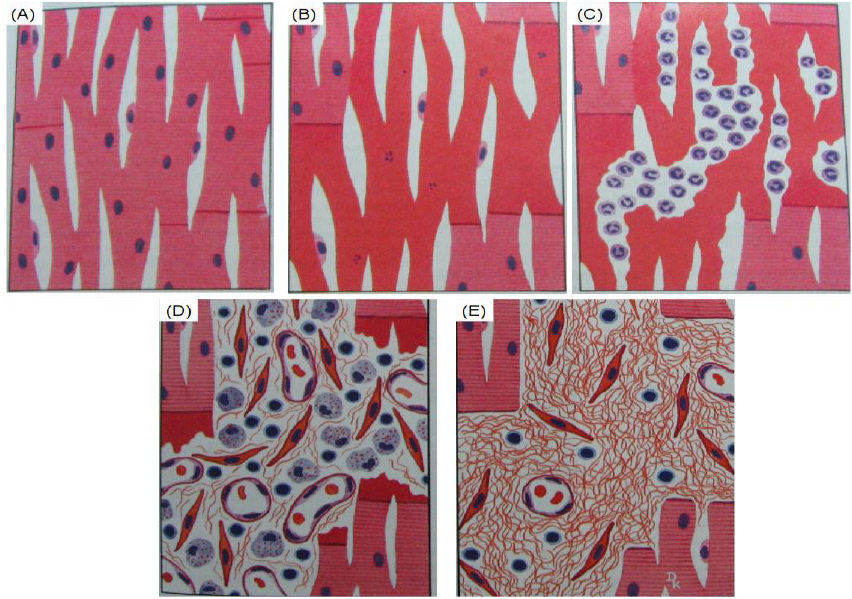
Figure 3. Myocardial infarction and the remodeling process: ( A ) normal myocardium, with clear nucleus and elongated actin fibers and ( B ) 12–18 h post-MI, the nucleus starts to dissociate and a wavy actin fiber emerge at the infracted sites; ( C ) 24 h post-MI, macrophages (cells with multiple nuclei) start to penetrate and the dead cells are removed by phagocytosis; ( D ) 3 weeks post-MI, fibroblasts are attracted to the infracted area and start to deposit collagen fibers in the area; ( E ) 3 months post-MI, the remodeling process is nearly complete. Collagen scar tissue has formed